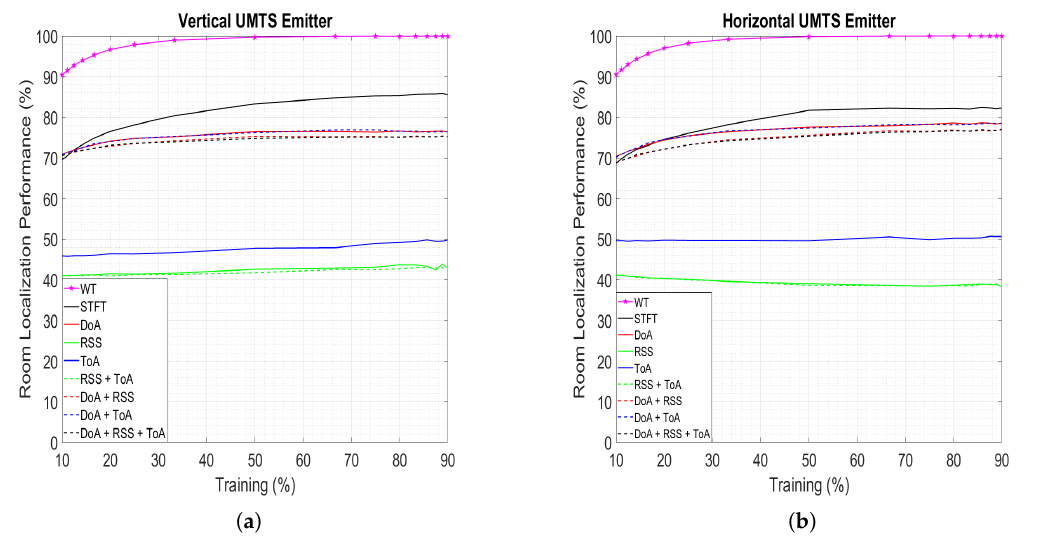
Figure 3. Room localization performance as a function of increased Weighted K -Nearest-Neighbor (W K NN) training percentages for both vertically and horizontally polarized UMTS non-cooperative emissions. ( a ) Vertical UMTS Transmitter, ( b ) Horizontal UMTS